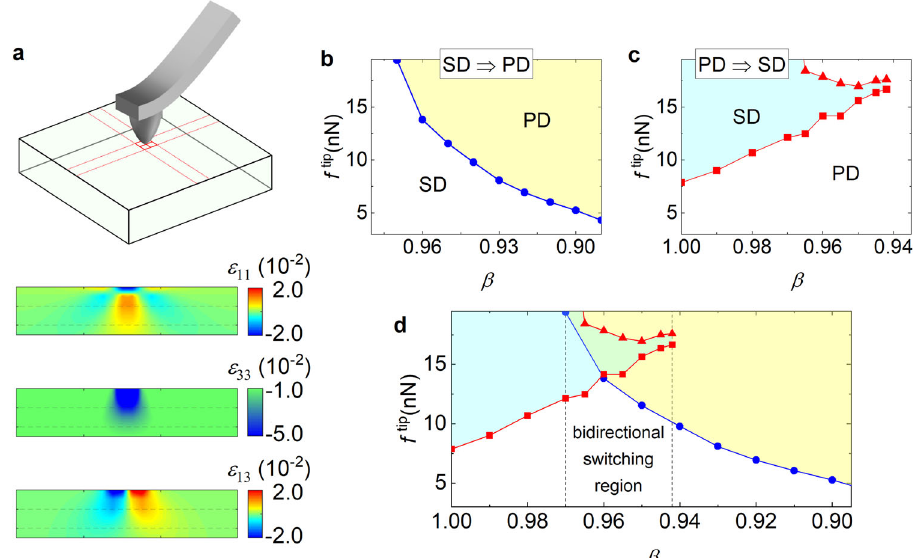
Fig. 4 Phase diagrams for bidirectional mechanical switching. a The point force mechanical model and distribution of tip-force-induced strain fi eld ε ext , ε ext , and ε ext in the fi lm. b The f tip – β phase diagram for SD → PD switching. c The f tip – β phase diagram for PD → SD switching. 11 33 13 d The f tip – β phase diagram indicating the bidirectional mechanical switching